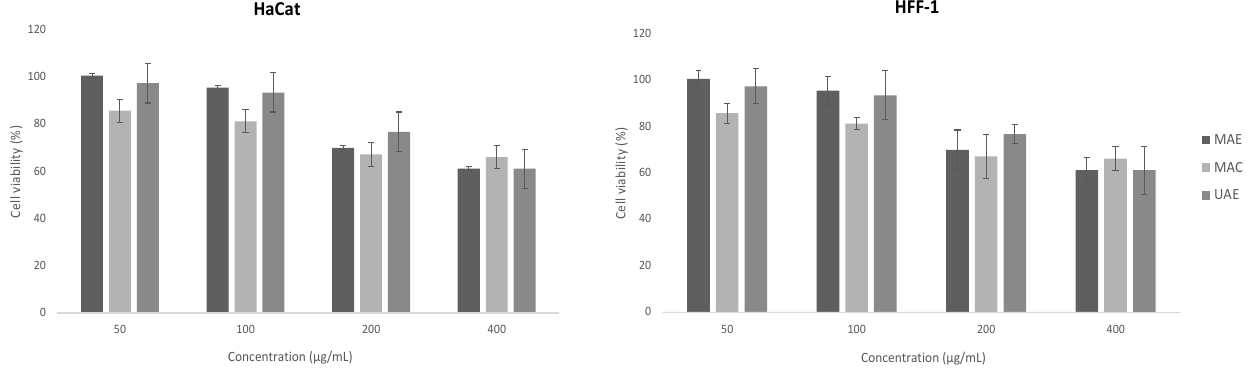
Figure 2. Effect on pomegranate leaves extract on viability of HFF-1 (human fibroblasts) and HaCaT (human keratinocytes) cells at different concentrations using the SRB assay. Positive control: Triton X-100 at a final concentration of 1% ( w/v ).